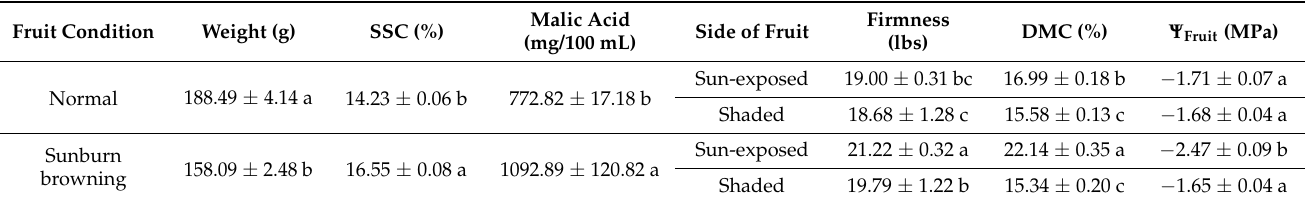
Table 1. Fruit weight, soluble solids content (SSC%), malic acid concentration, firmness, dry matter content % (DMC%), and fruit hypanthium water potential ( Ψ Fruit ) of normal and sunburn browning ‘Ambrosia’ apple at